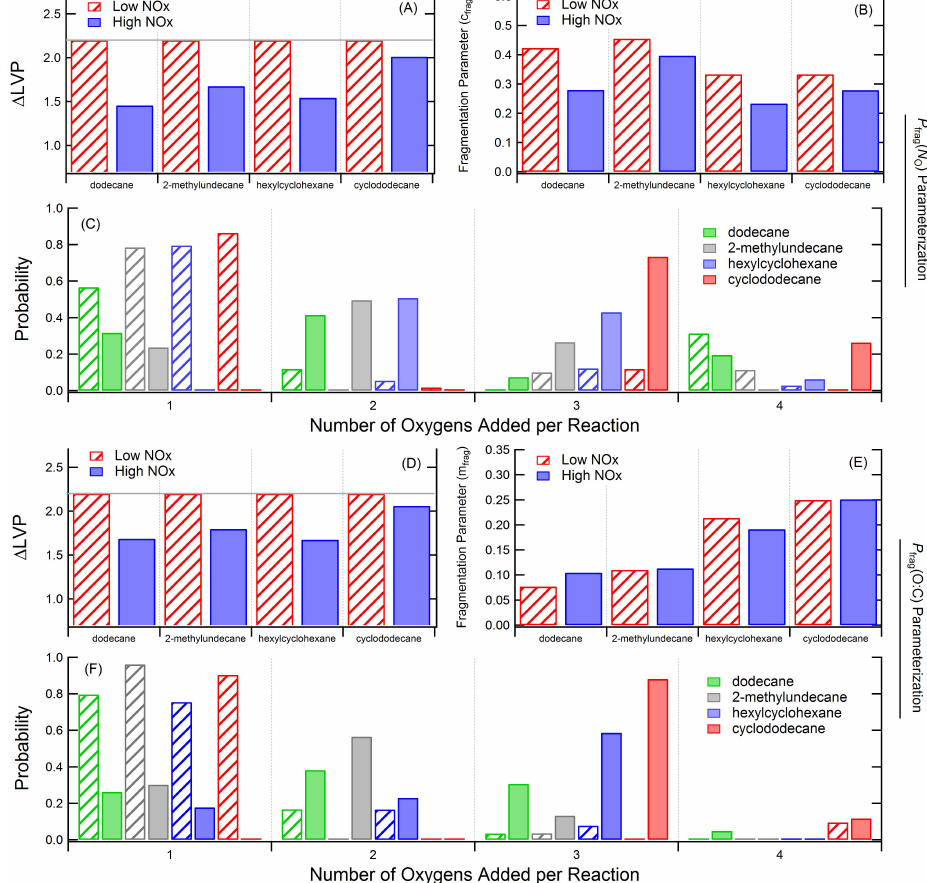
Fig. 2. Best-fit SOM parameters for dodecane, 2-methylundecane, hexylcyclohexane, and cyclodecane under low-NO x (hashed) and high- NO x (solid) conditions for different parameterizations for fragmentation: (A–C) used P frag (N O ) while (D–F) used P frag (O:C). Results are shown for 1 LVP ( A and D ), the fragmentation parameter ( B and E ) and the oxygen addition array ( C and F ). The model was fit simultaneously to the observed C OA and O:C. The two fragmentation parameterizations give generally similar results. Note that for the fragmentation parameter, larger values of c frag correspond to greater fragmentation while smaller values of m frag correspond to greater fragmentation. The grey line in (A) and (D) indicates the upper-limit constraint on 1